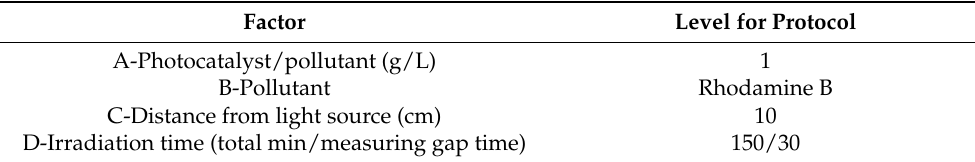
Table 4. Proposed photocatalysis